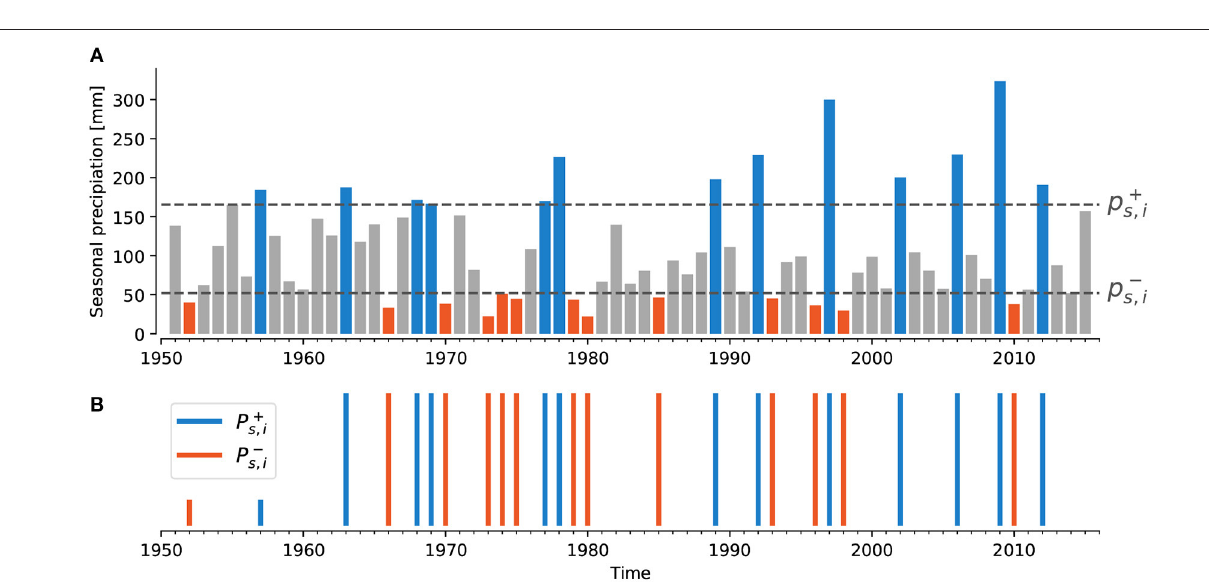
(blue bars) are considered very wet while those below p − s , i (red bars) are considered very dry for the i